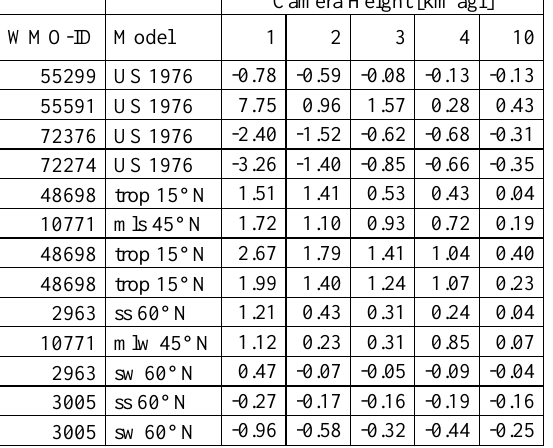
Table 3. Difference of the atmospheric refraction [ μ rad] between Eqn (4) and Eqn (9) for different camera heights and for all sites. The difference is largest below 2 km camera height.